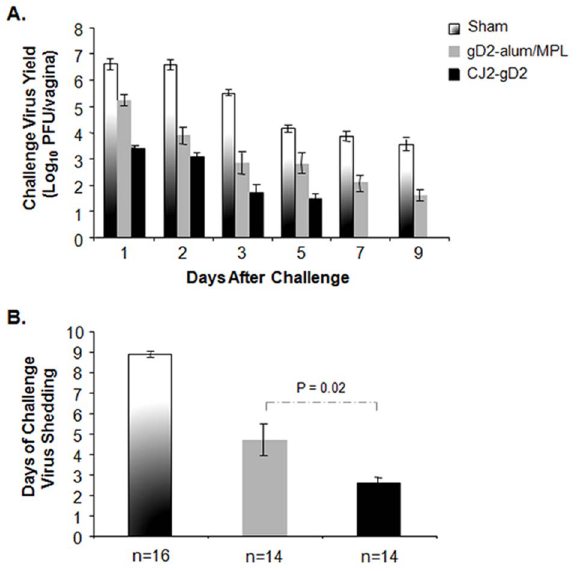
Figure 3. CJ2-gD2 exhibits superior vaccine efficacy than gD2- alum/MPL subunit vaccine in protecting against intravaginal wild-type HSV-2 infection in guinea pigs. Female guinea pigs sham-immunized with DMEM or immunized with gD2-alum/MPL or CJ2-gD2 described in Fig. 2 were challenged intravaginally with 5 6 10 5 PFU of HSV-2 strain MS. Vaginal swabs were taken on days 1, 2, 3, 5, 7, and 9 post-challenge. Infectious virus on swab materials was determined by standard plaque assay in Vero cells. Viral yields are expressed as the means 6 SEM for individual swabs (A). The duration of viral shedding is represented as the mean number of days during which infectious virus was detected in vaginal swabs 6 SEM (B).